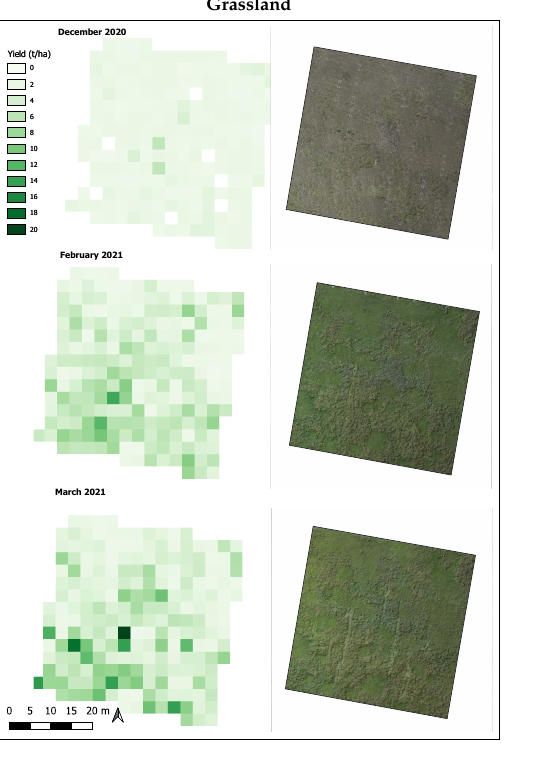
Figure 7. Example predicted pasture yield maps of both the grassland and woodland field plots ( a , b ). The left hand sides of each plate are the re-scaled RPAS-based model predictions of yield and the right hand side are the RPAS derived high-resolution images overlaid onto the associated pasture height models from the December, February and March RPAS captures.